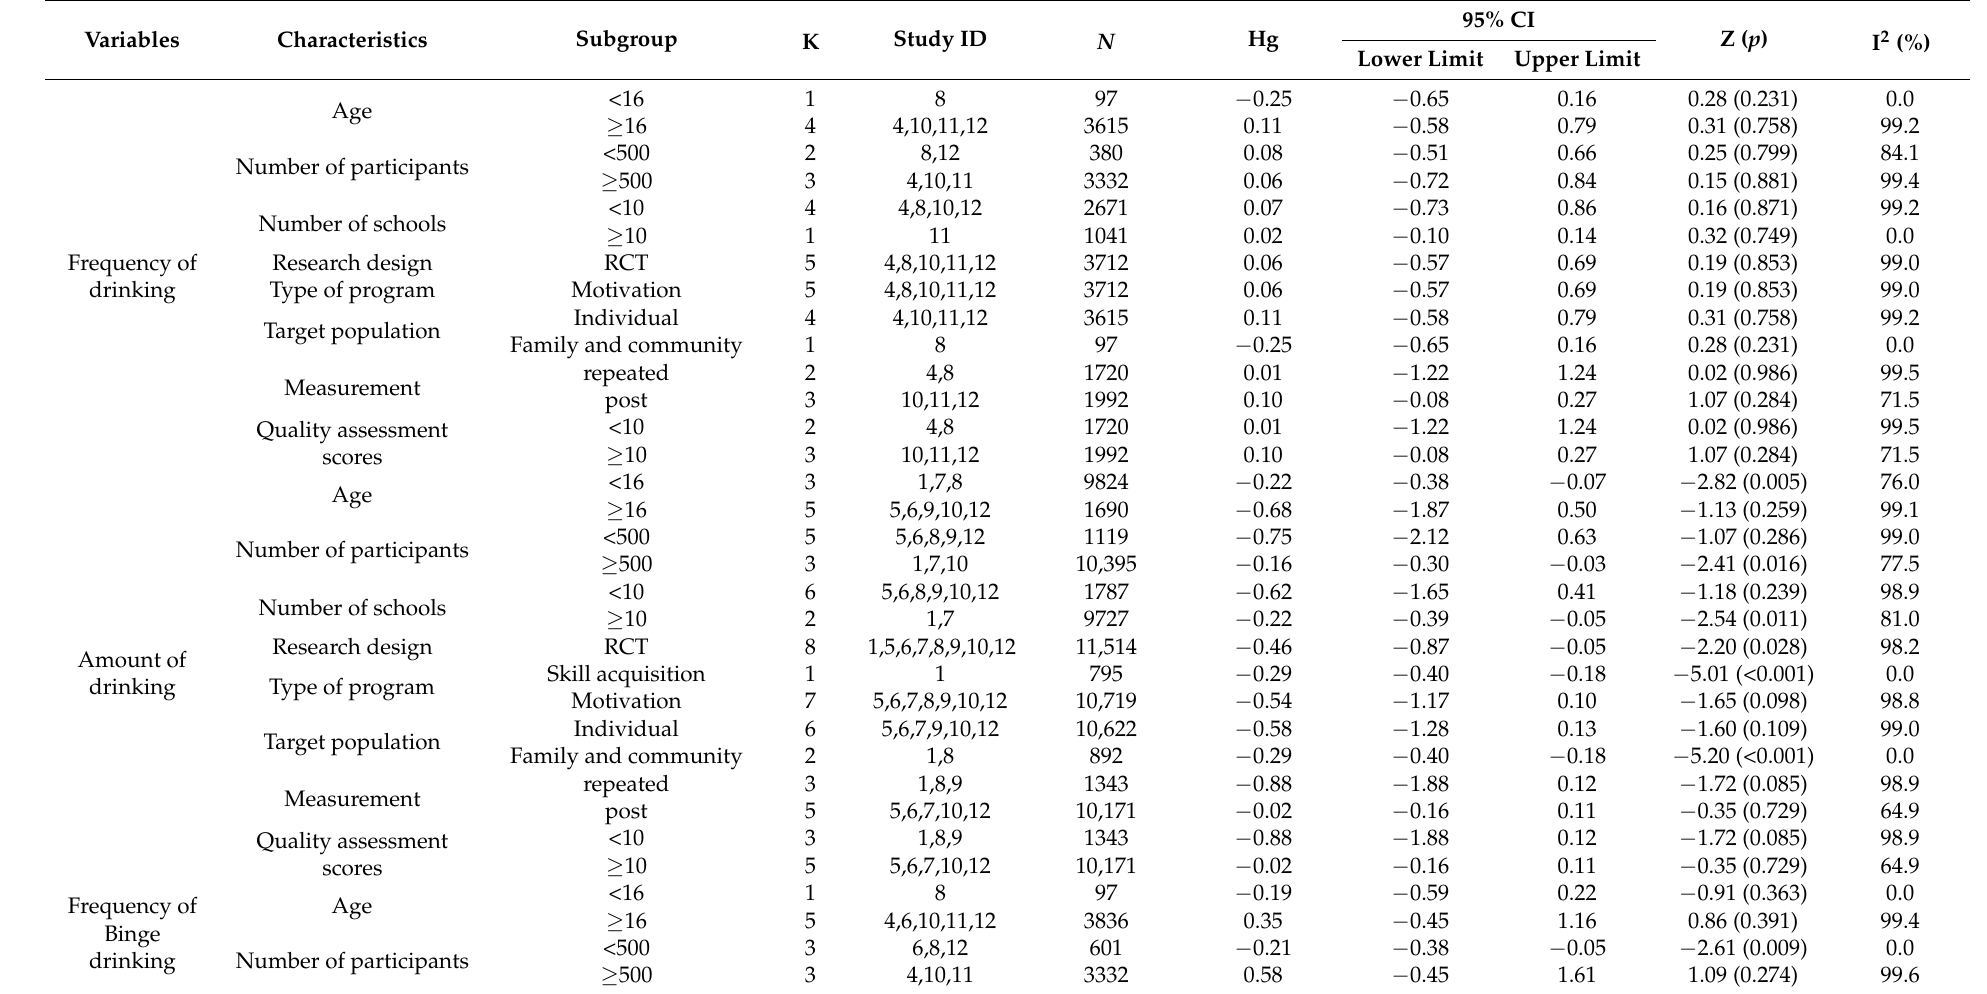
Table 4. The effect size of alcohol prevention interventions on drinking behaviors by intervention